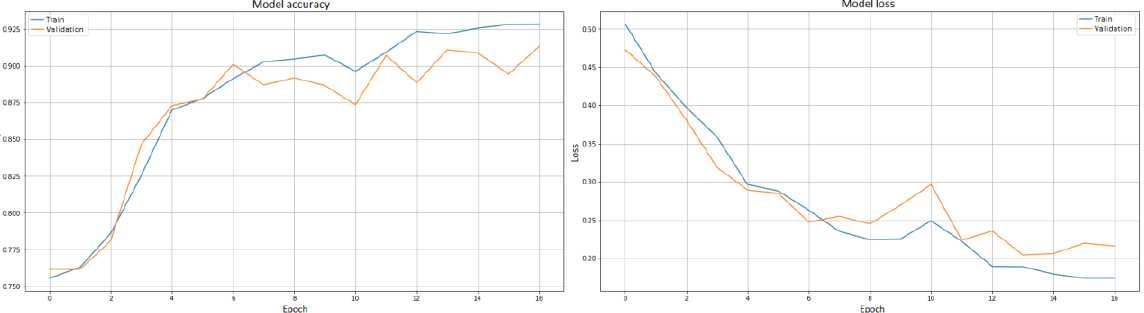
Figure 11. Subotica—accuracy and loss function curve.